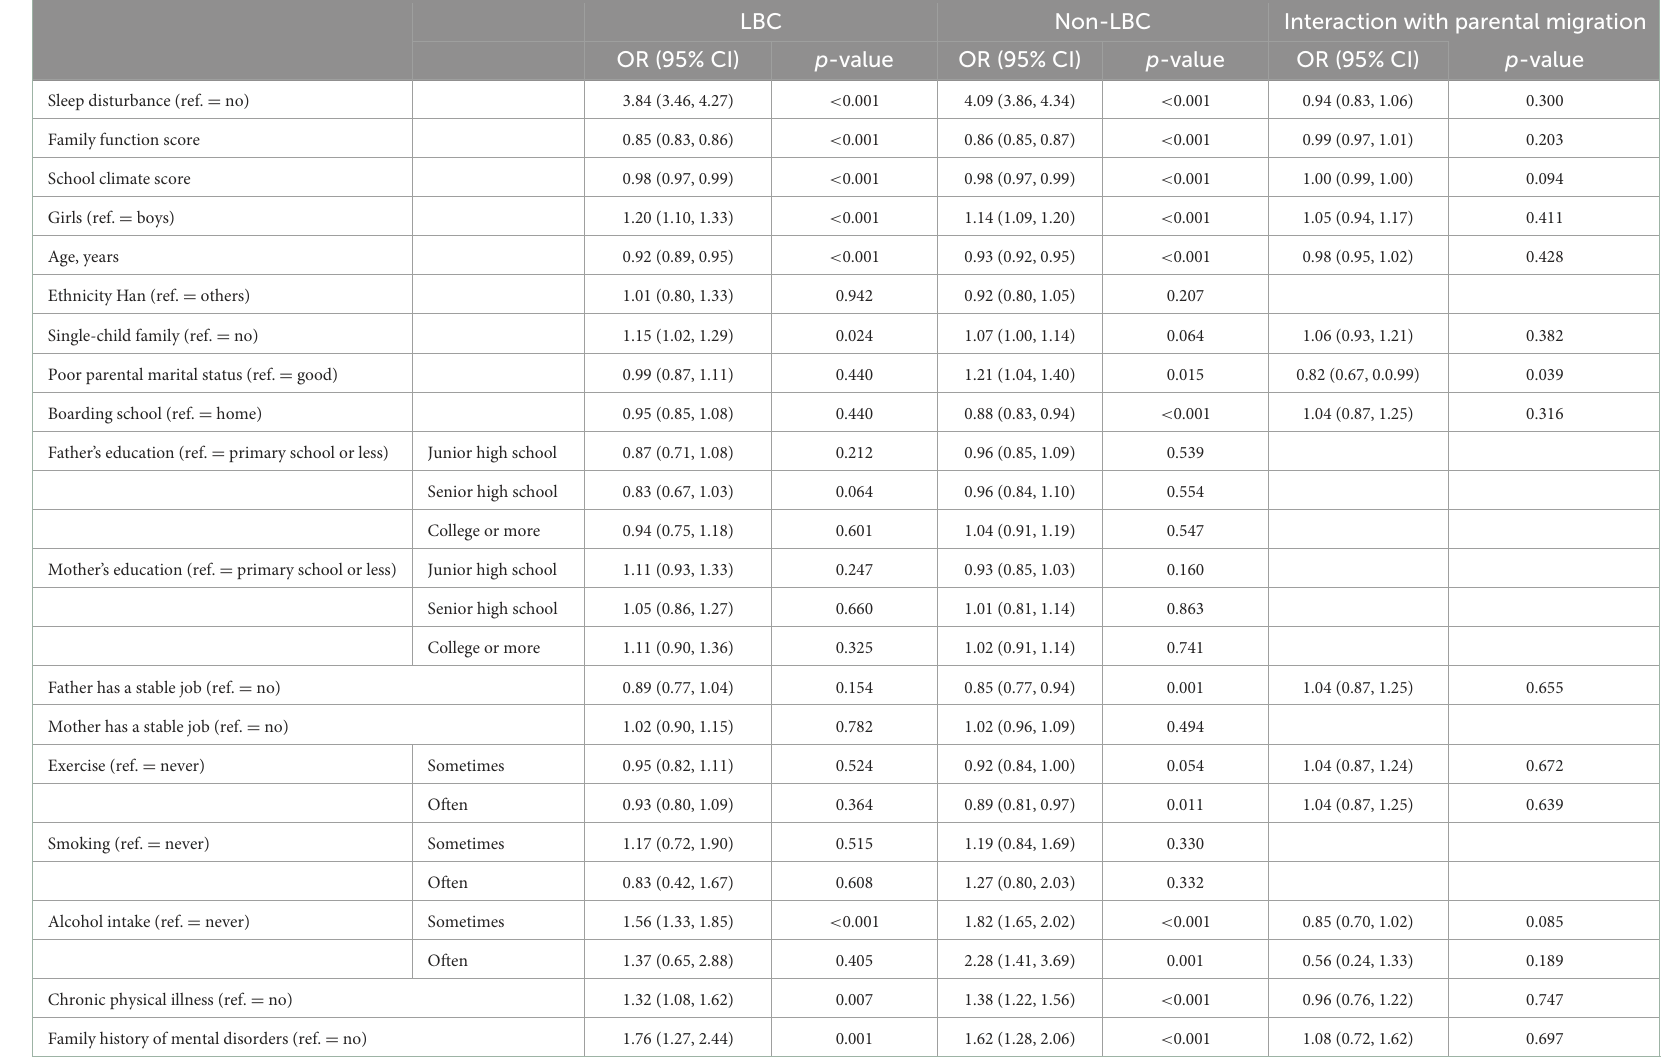
TABLE 4 Multinomial logistic regression of PLEs in LBC and